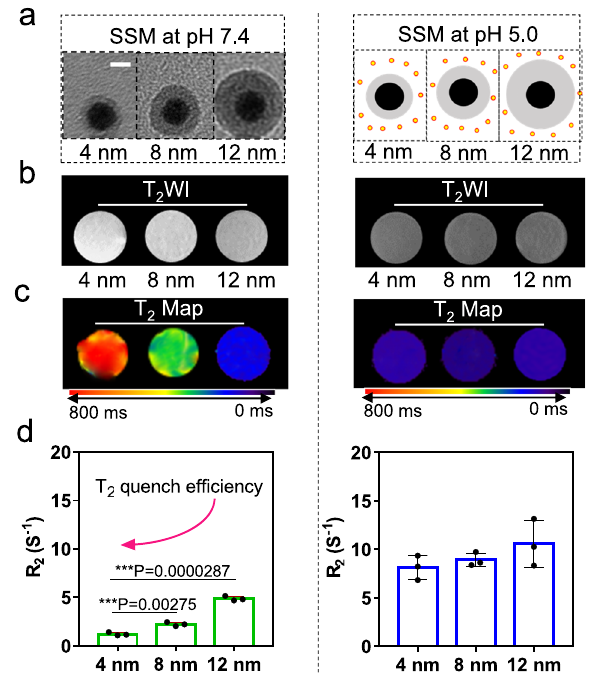
Fig. 3 | Thedistance-dependent quenching effect of MnO 2 toT 2 contrast signal ofthe SPIO core.a TEM images and schematic illustration of the structureofSSM (SPIO@SiO 2 @MnO 2 )withdifferentSiO 2 thicknesses(4,8,and12nm)atpH7.4and 5.0,scalebar=12nm.TheSiO 2 intermediatelayerworksasarulertoinvestigatethe in fl uence of distance on the T 2 quenching effect; b T 2 -weighted images, c T 2 Map, and d R 2 of SSM samples with different SiO 2 thicknesses (4, 8, and 12nm) at pH 7.4 and 5.0. T 2 -weighted images and T 2 Map are representative data from three inde- pendent samples. R 2 data are presented as mean±SD from three independent samples. The two-tailed Student ’ s t -test is employed for the statistical analysis. * P <0.05; ** P <0.01; *** P <0.001. Source data are provided as a Source Data fi